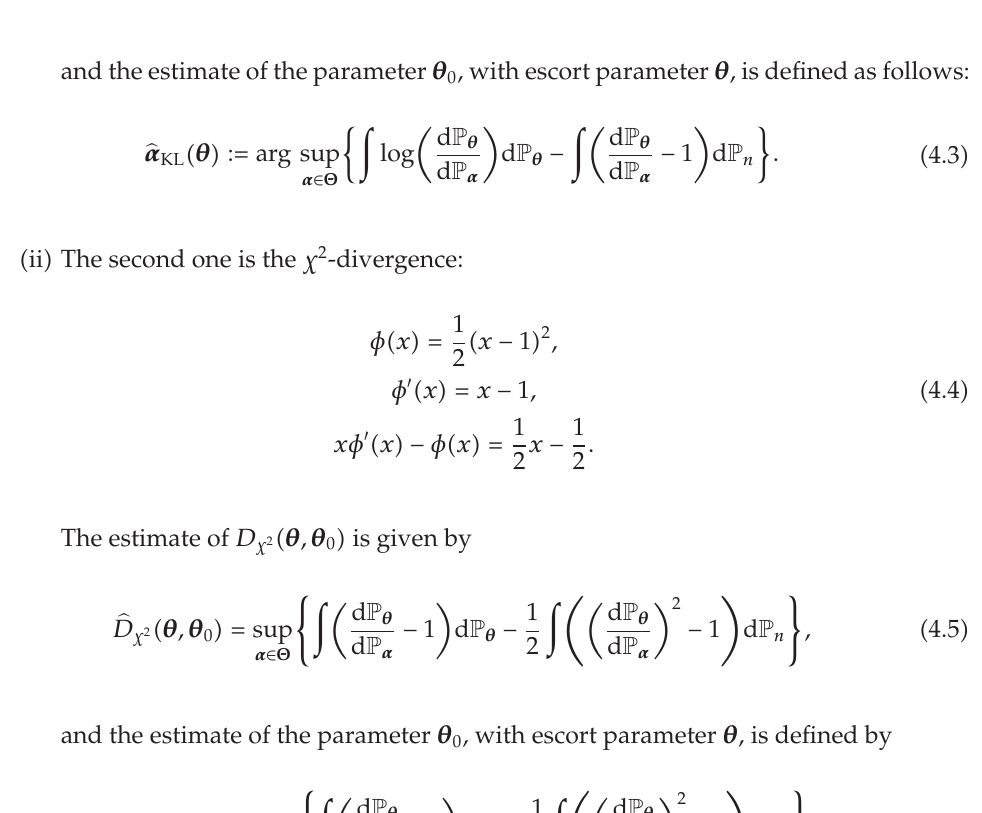
Figure 1: Criterion for the normal location